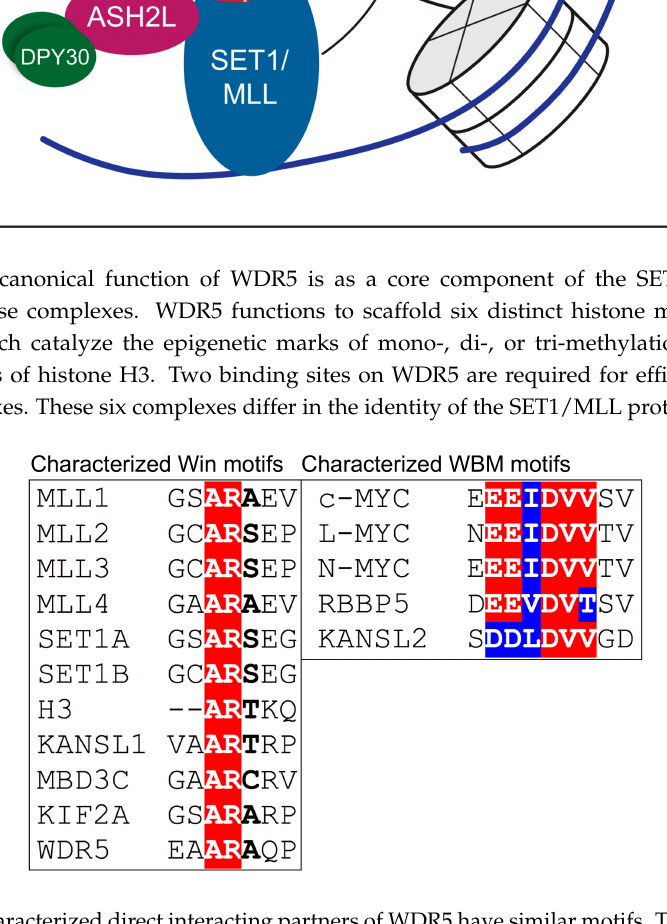
Figure 5. The characterized direct interacting partners of WDR5 have similar motifs. The Win motif and WBM motif sequences for WDR5-interacting proteins mentioned in this review are shown. The Win motifs are all centered on an arginine, while the WBM motifs are a specific combination of acidic and hydrophobic residues. Residues highlighted in red are identical. Residues highlighted in blue are